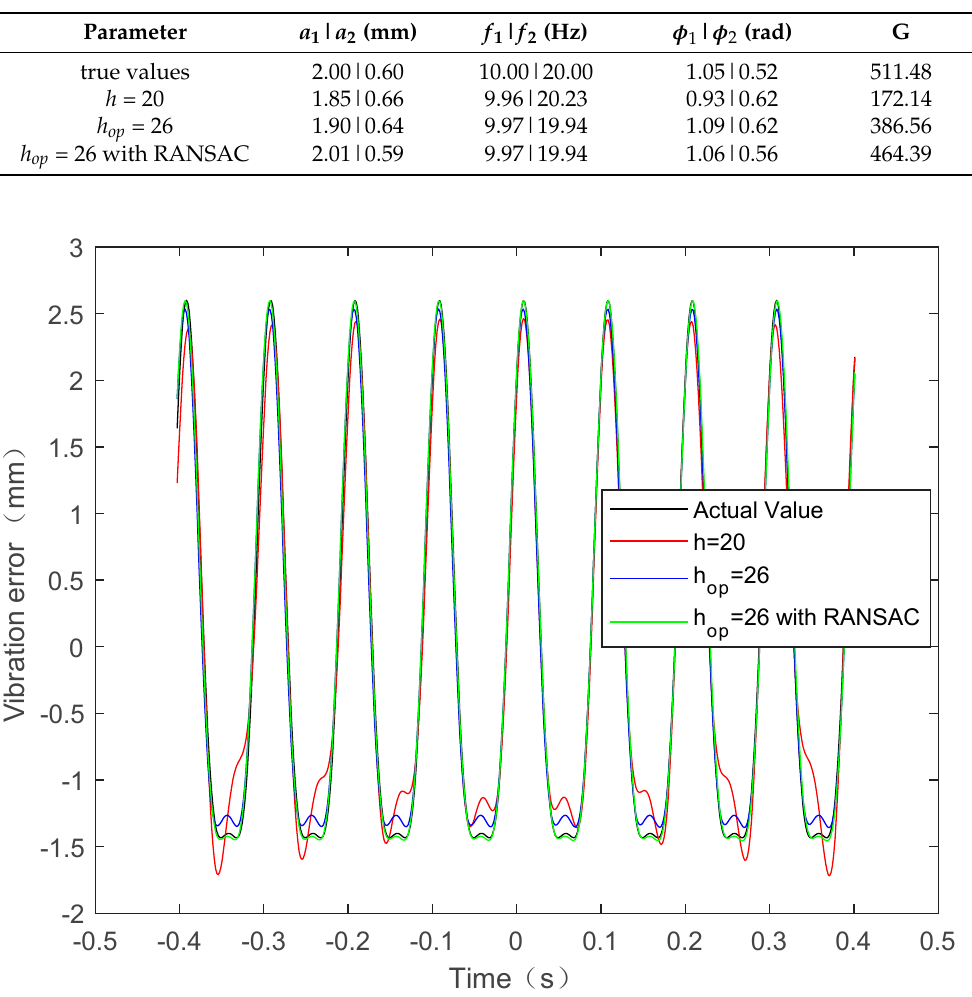
Figure 9. True and estimated multi-component vibration error.